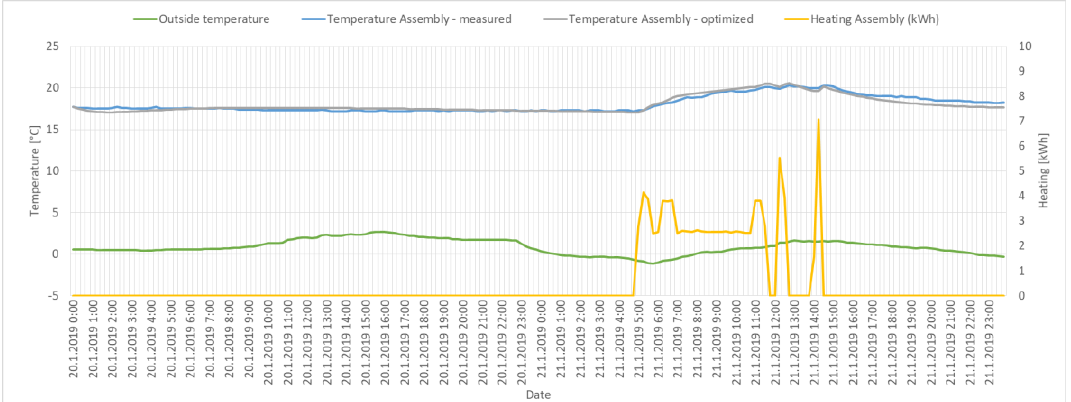
Figure 12. Results of optimized model with Winter 2-3 scenario.